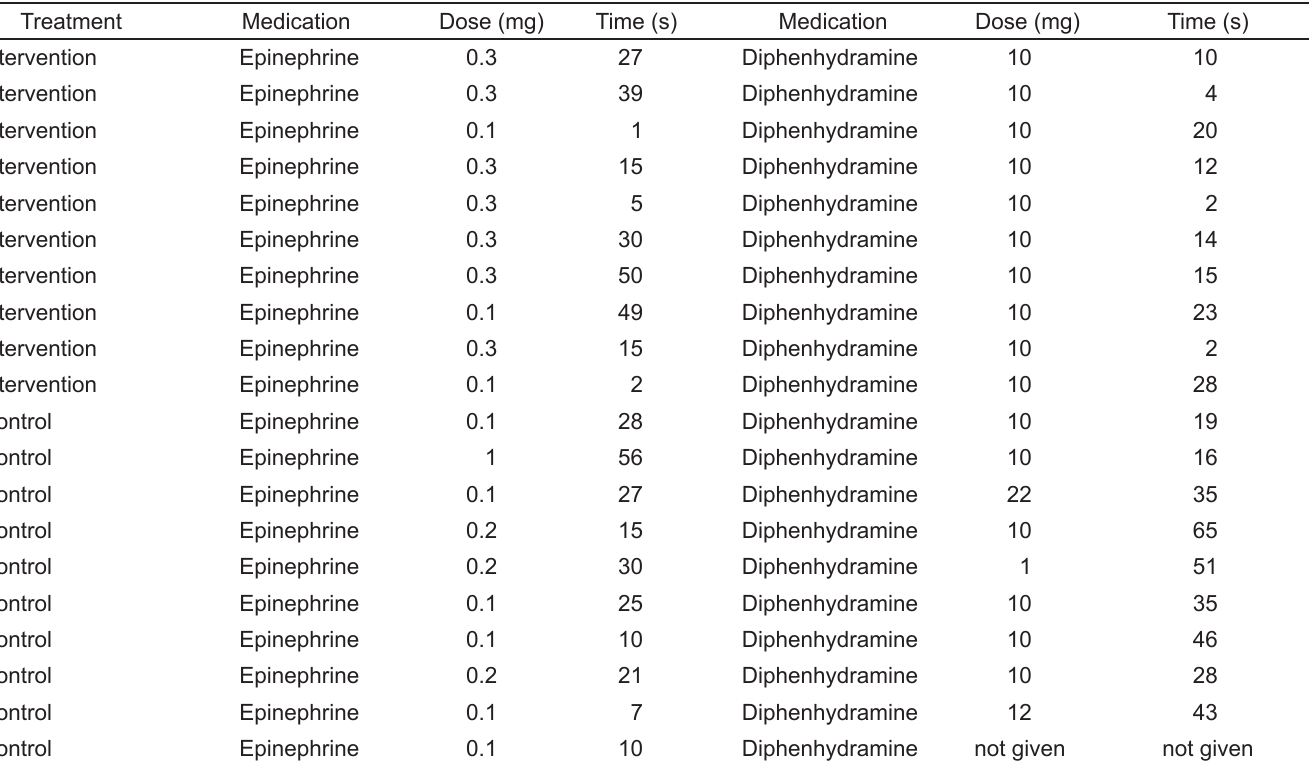
Table 2b. Case two - anaphylaxis. Dose and time for each medication in each